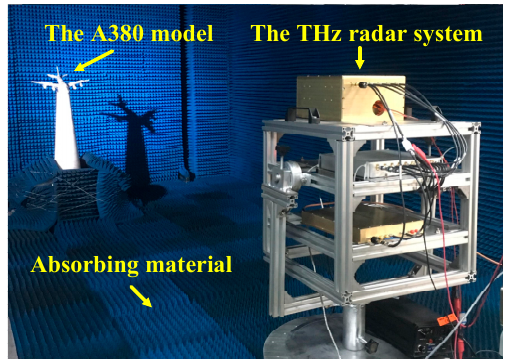
Figure 9. Experimental scenario of an A380 model.